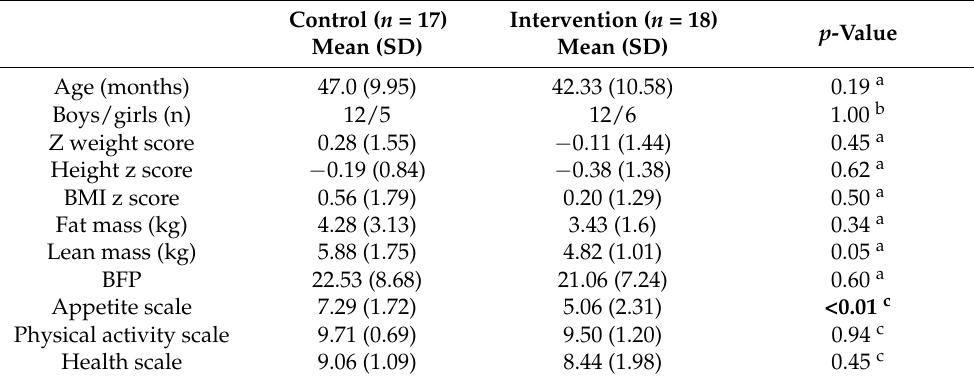
Table 2. Baseline data of the participants of the control and intervention